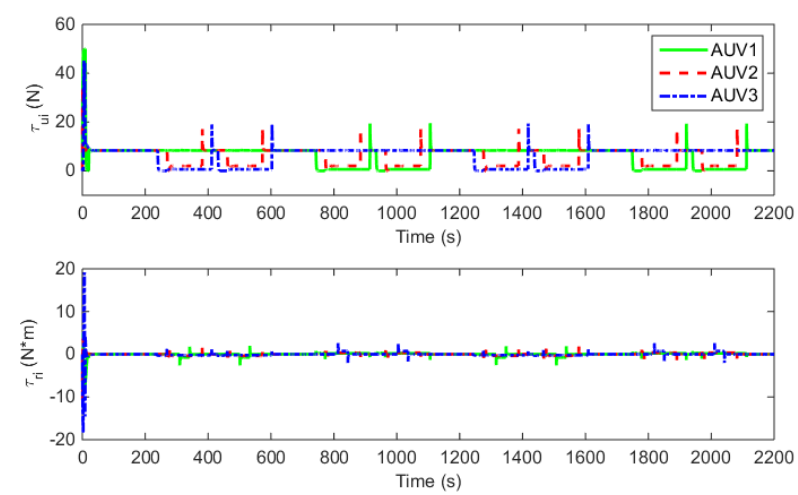
Figure 11. Surge and yaw angular velocities of three AUVs.